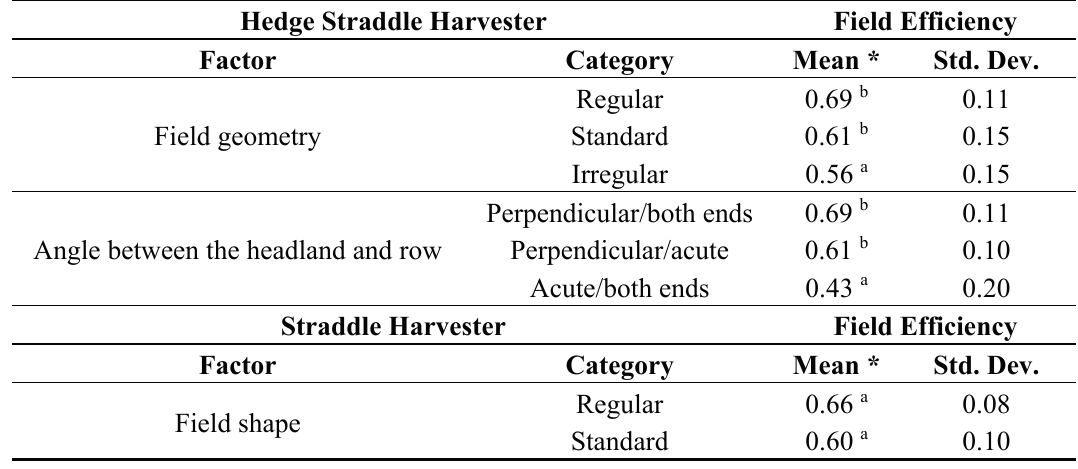
Table 3. Field efficiency based on the field shape and the angle between the headland and